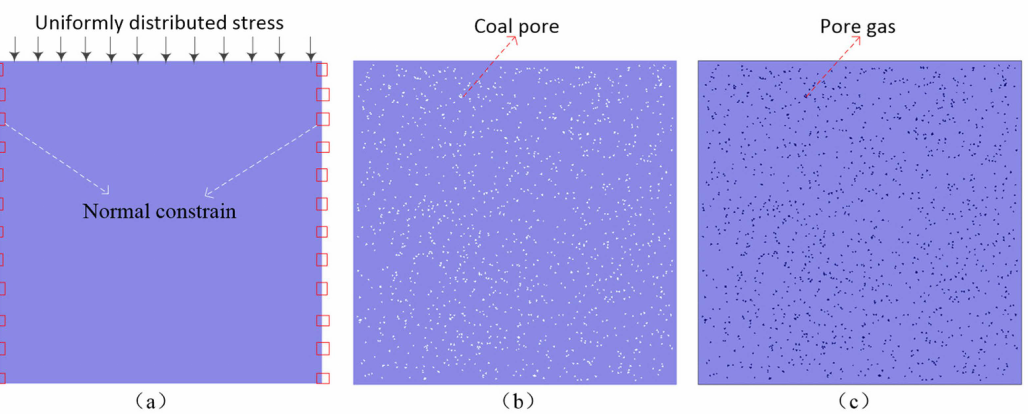
Figure 2. The coal models: ( a ) coal without pores; ( b ) coal with pores; and ( c ) coal with pore gas.